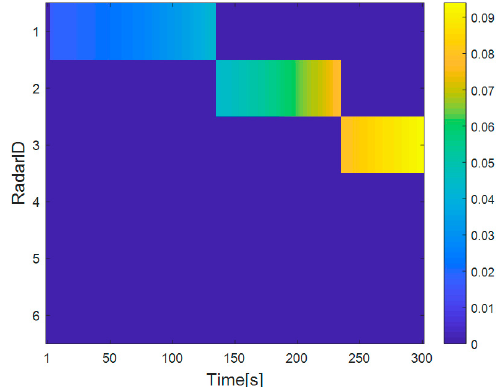
Figure 4. Target 1 dwell time allocation ratio.